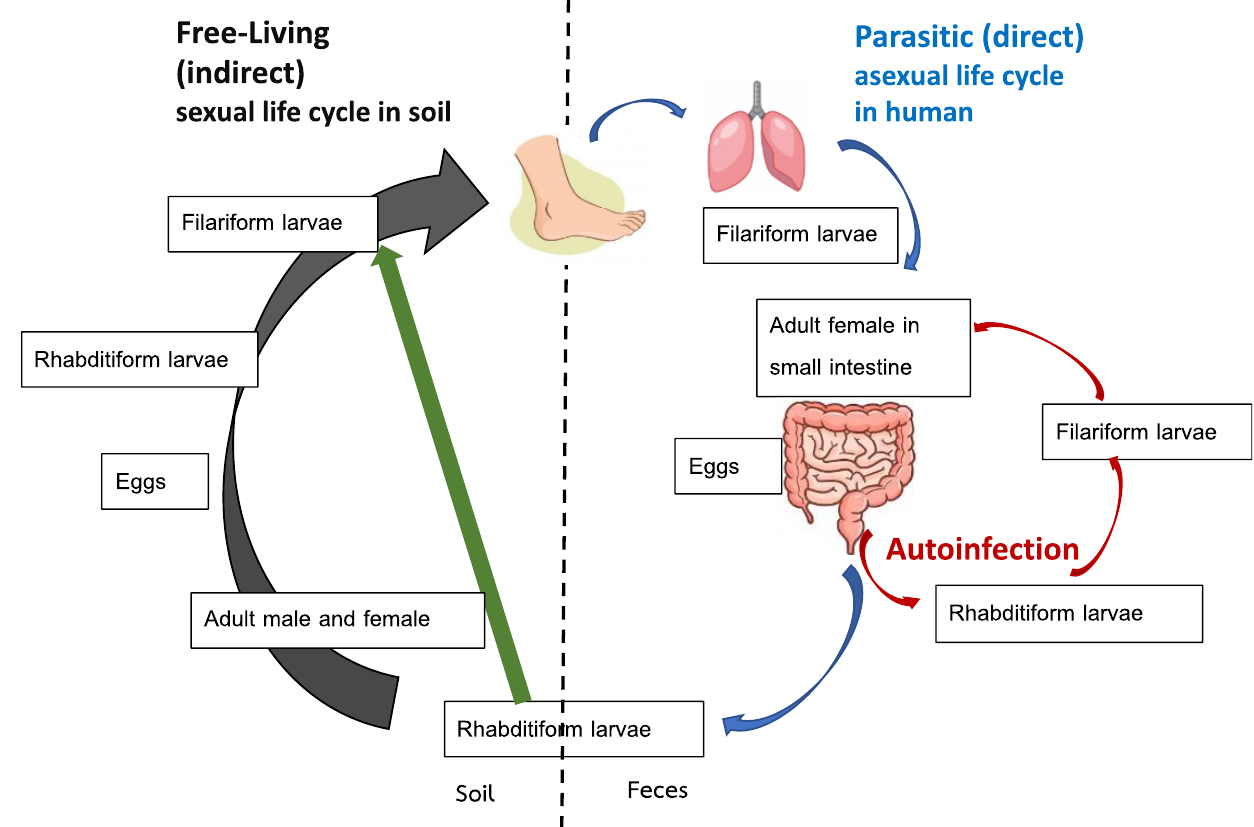
Figure 1. Life cycle of Strongyloides stercoralis . Adapted from reference no. [17] .